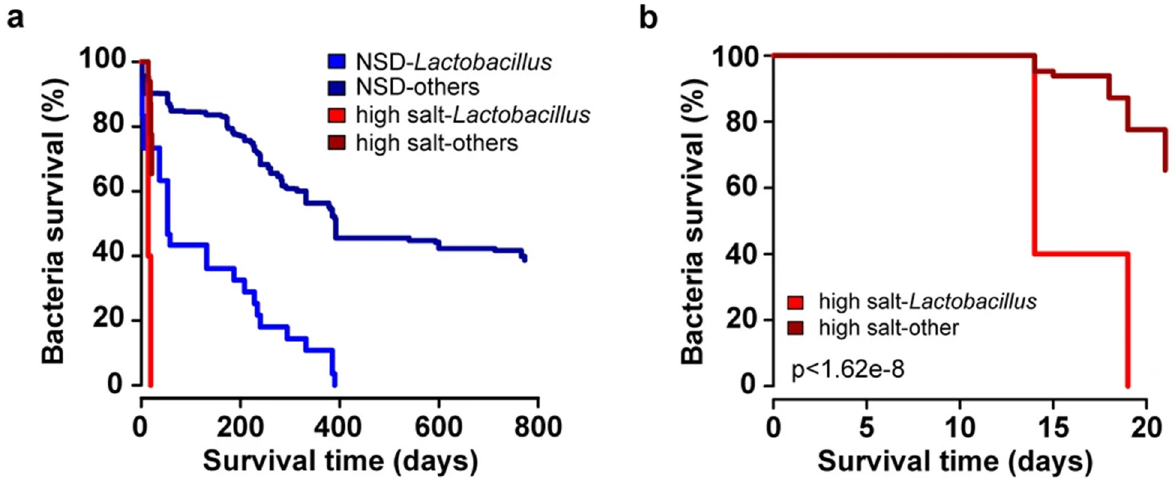
Figure 3. Effects of high-salt challenge in healthy human subjects. The left panel displays Kaplan-Meier survival curves for gut bacteria in individuals under high-salt intervention (red; N = 12) and healthy controls (blue; N = 121). The bright shades of red and blue indicate the Lactobacillus species while the dark shades indicate the set of all other detected gut bacteria. The right panel displays the results for the salt intervention group during the first 20 days of the intervention. In summary, high-salt challenge decreases the abundances of several gut microbial species while the loss of Lactobacillus species is particularly rapid. NSD, normal salt diet. Adapted by permission from the Springer Nature: Nature, Salt-responsive gut commensal modulates TH17 axis and disease, Wilck et al. [27].